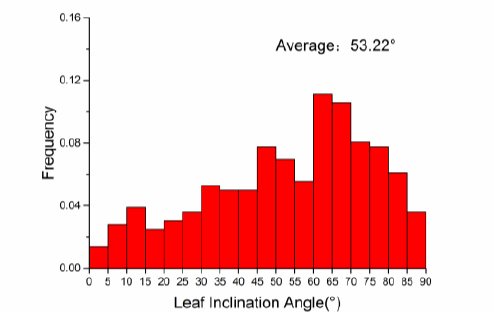
Figure 5. LAD histogram of the artificial tree with manual measurement The TLS point cloud of this artificial tree was acquired by Riegl VZ-1000 instrument at the height of 1m. The horizontal distance between the tree and the laser scanner was 5m. The angle stepwidth was set as 0.03° and other parameters of the scanner was shown in Table 1. The original point cloud is shown in Figure 6.